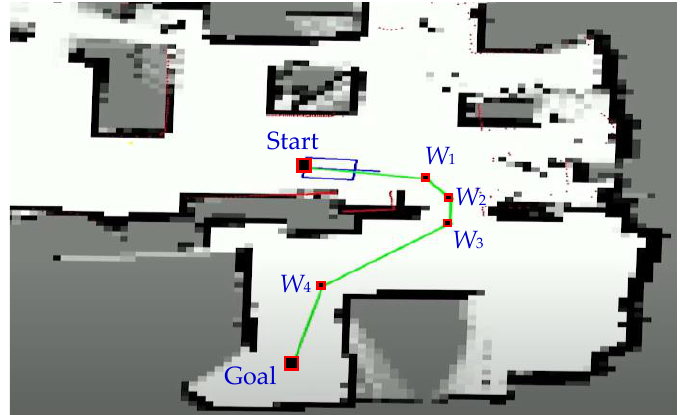
Figure 1. The moving task of the differential drive robot. The relationship between the current robot position and the next waypoint is needed for the design process and it is indicated in Figure 2 [10].